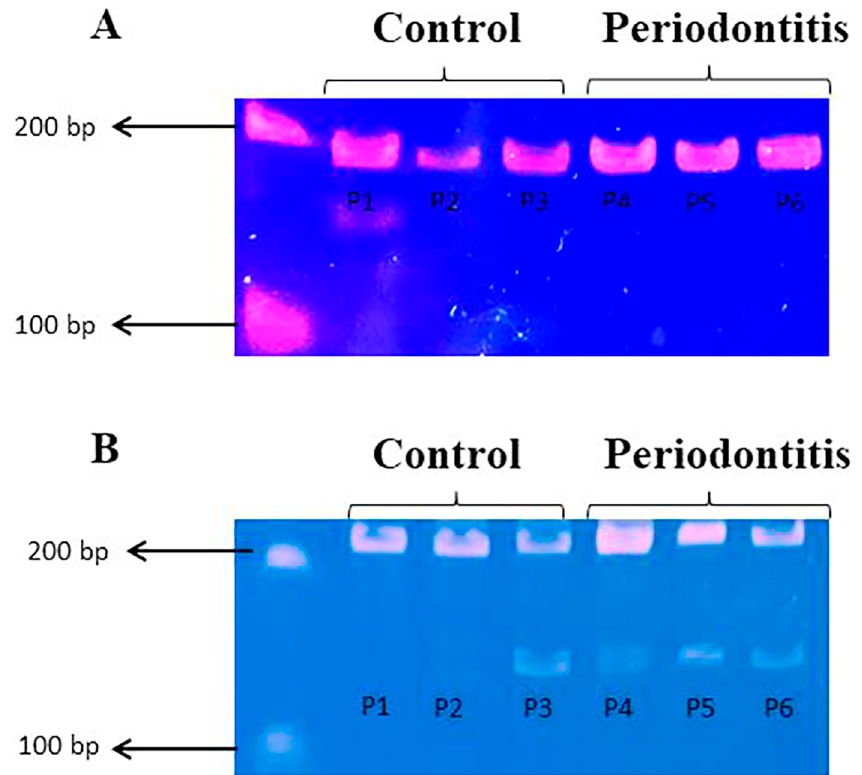
Figure 3- Representative bands stained with Gel Red of SOD1 and CAT following the COBRA method for both control and periodontitis groups. (A) Amplicons after digestion for methylated (139 bp) and unmethylated (175 bp) status of the SOD1 gene promoter; (B) Amplicons after digestion for methylated (167 bp) and unmethylated (199 bp) status of the CAT gene promoter. P1-P6=patient 1–patient